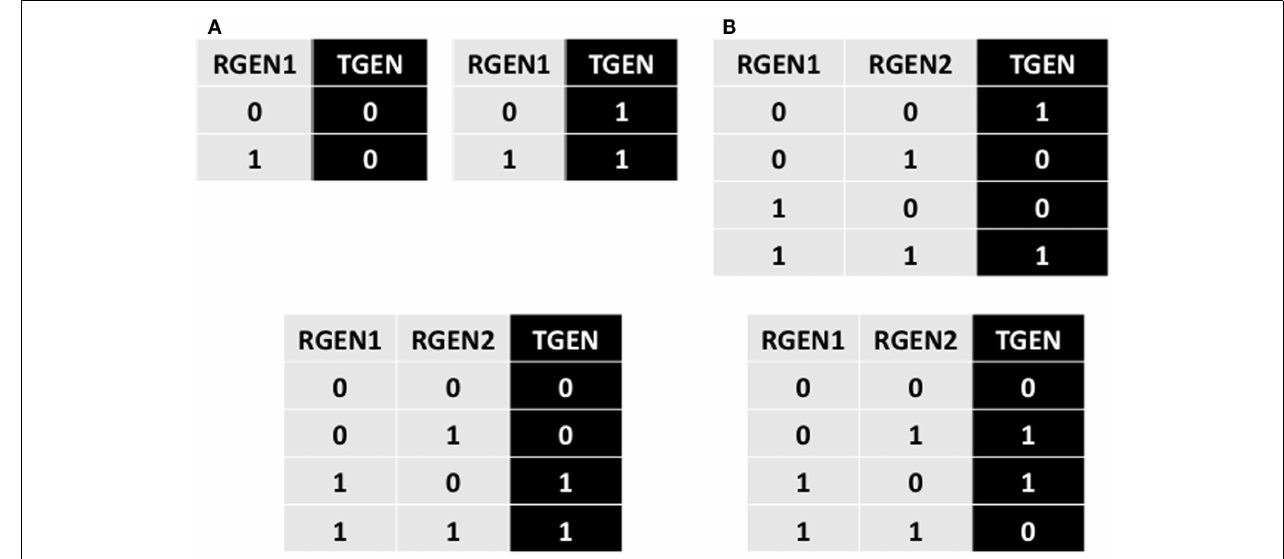
depends only on the value of RGEN1 but not on the expression value of RGEN2. (B) Truth tables with global ambiguous regulation ofTGEN by RGEN1 and RGEN2. In both truth tables,TGEN’s expression value is positively and negatively regulated by RGEN1 and RGEN2 indicating that both factors are ambiguous regulators